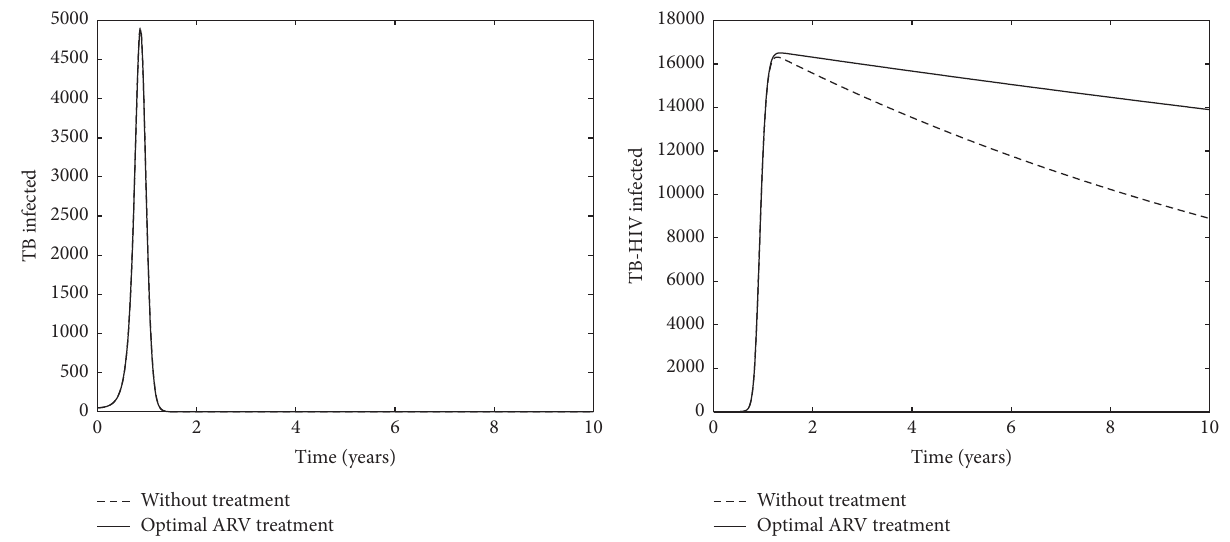
Figure 10: The dynamics of 𝐼 𝑡 and 𝐼 ℎ𝑡 using control 𝑢 ∗ 2